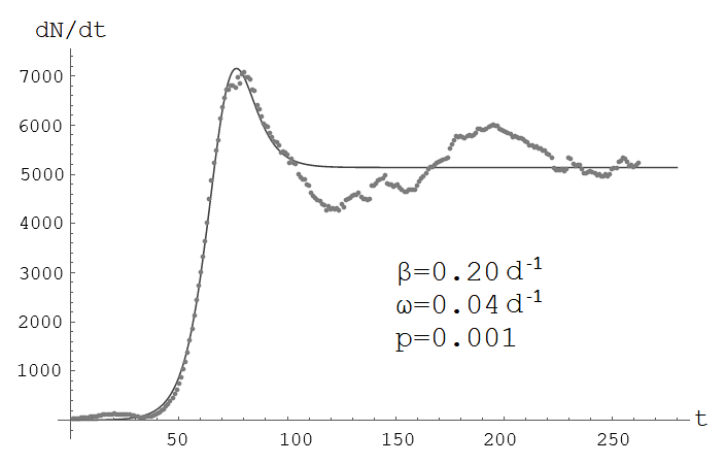
Figure 5. Daily deaths in the COVID-19 world pandemic versus time (dots) and model dependence (solid